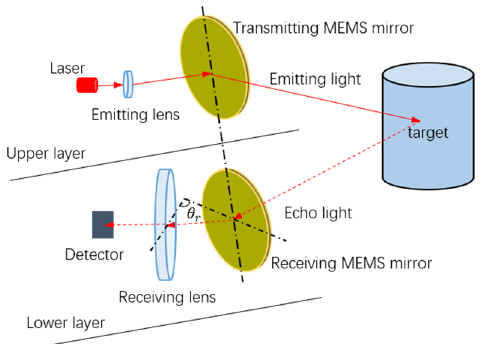
Figure 1. Semi-coaxial micro-electro–mechanical system (MEMS) light detection and ranging (LiDAR), based on a synchronous MEMS mirror pair.